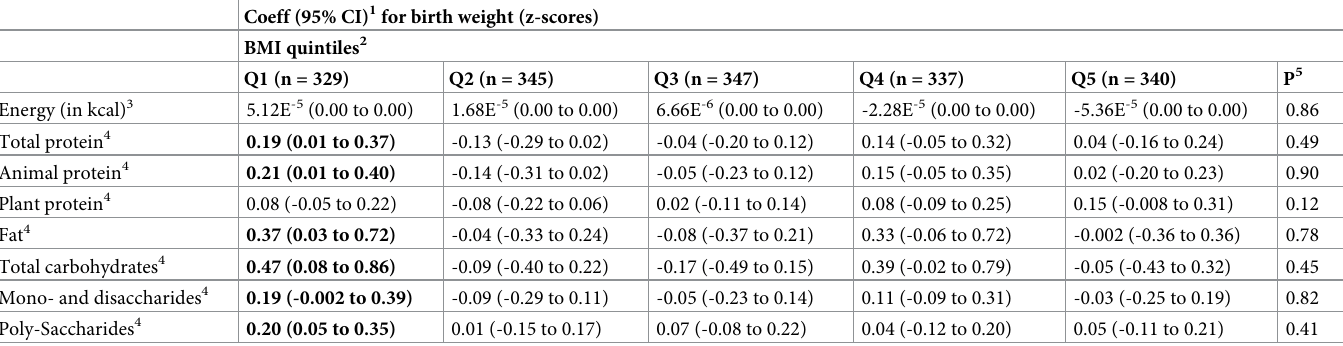
Fig 2. Mean birth weight (z-scores; adjusted for gestational age) in quintiles of macronutrient intake (95% confidence intervals). A. Total protein, B. animal protein, C. plant protein, D. fat, E. carbohydrates, F. mono- and disaccharides, G. polysaccharides.